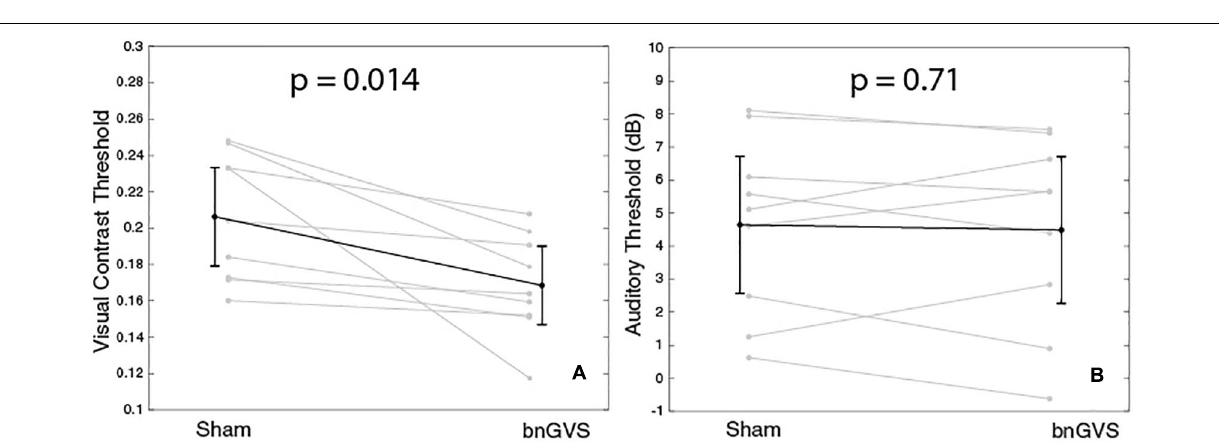
Judge #1 on the visual task ( Figure 6A ),